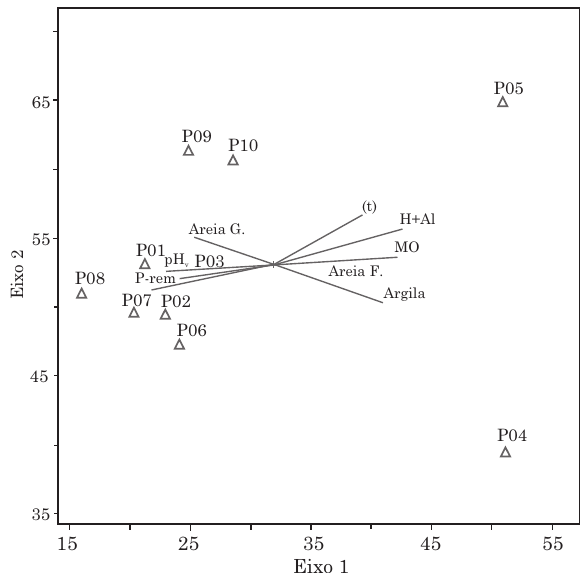
Figure 3. Ordination axis produced by canonical correspondence analysis of the 10 plots sampled in rocky grassland vegetation; inter- relationships between the distribution of study environments and environmental soil